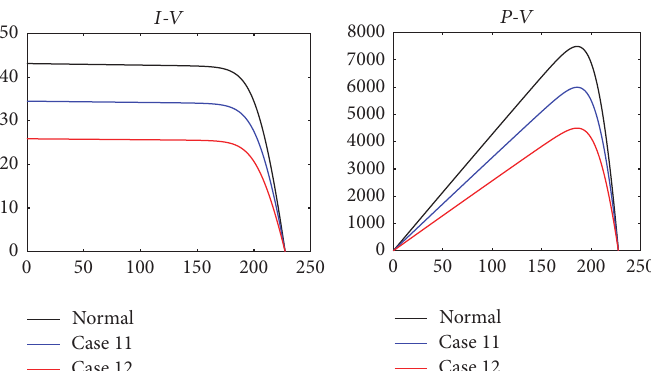
Figure 9: The PV array configuration for string